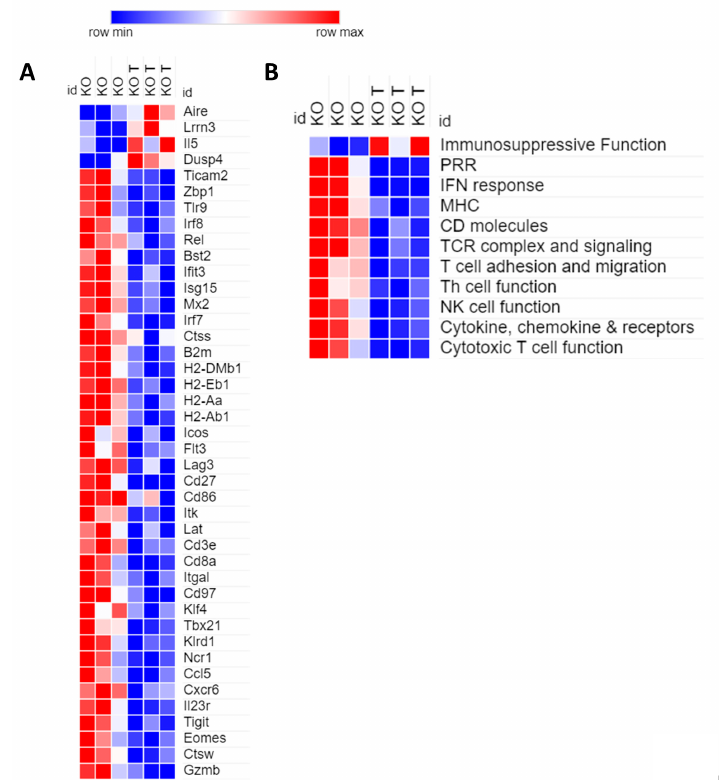
Figure 4. Sting loss affects immunogenic tumor remodeling according to NanoString RNA profiling. ( a ) The panel reports the heat map for representative differentially regulated genes between Sting knockout untreated (KO) and treated (KO T) tumors. Values were normalized by nSolver software and filtered according to p -value (<0.05) and fold (±1.5). ( b ) The genes were grouped in 11 immune-relevant categories to obtain an overview of the gained trend from NanoString analysis.